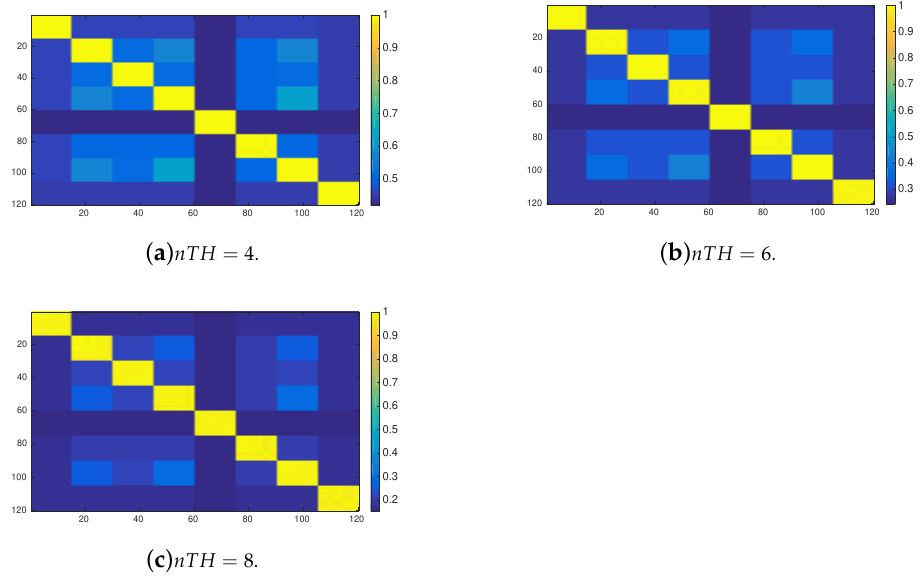
Figure 8. Possibilistic transition matrix, induced by the OPRF, powered after reaching a stationary possibilistic distribution ( P τ ) for the 120 tasks arranged into 8 clusters and different values of nTH .